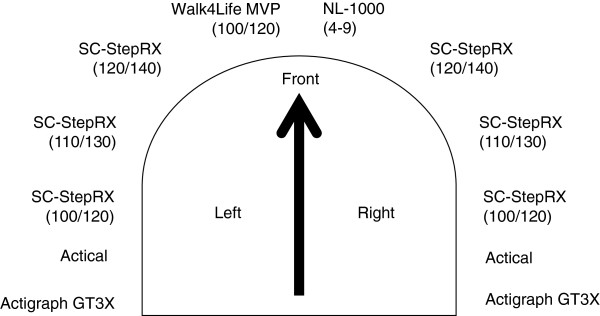
Placement of the physical activity monitors.